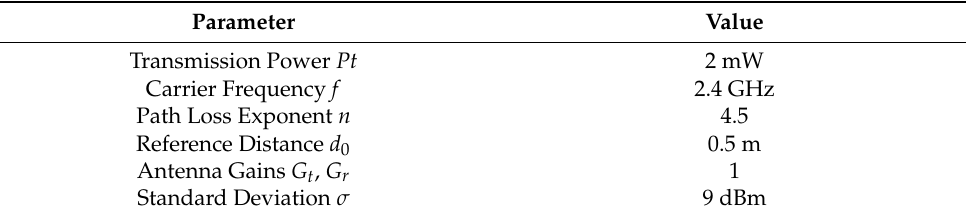
Table 2. Parameters of RSSI channel model.